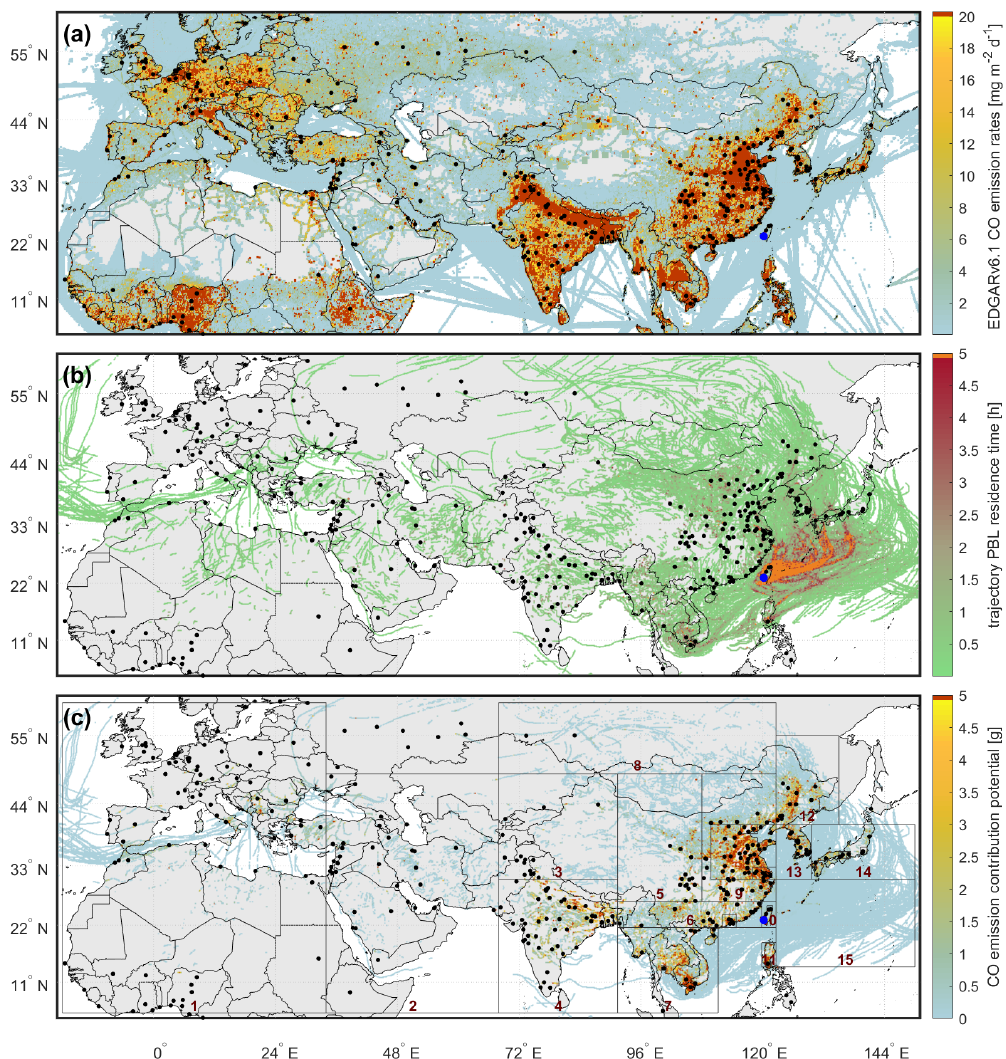
Figure 6. (a) EDGAR v6.1 CO emission rates from anthropogenic sources (March 2018), for clarity, not colour-coded below 0.01mgm − 2 d − 1 ; (b) PBL residence time of air parcels (for flights AS-03 to AS-14) cumulated for a grid resolution of 0 . 1 ◦ × 0 . 1 ◦ ; and (c) calculated CO emission uptake from PBL interpreted as emission contribution potential during EMeRGe-Asia. Boxes in (c) mark selected study areas (summarised in Table 4, right-hand side). Black dots mark cities with more than one million inhabitants; the blue dot denotes the home base of HALO (Tainan Airport, Taiwan) during